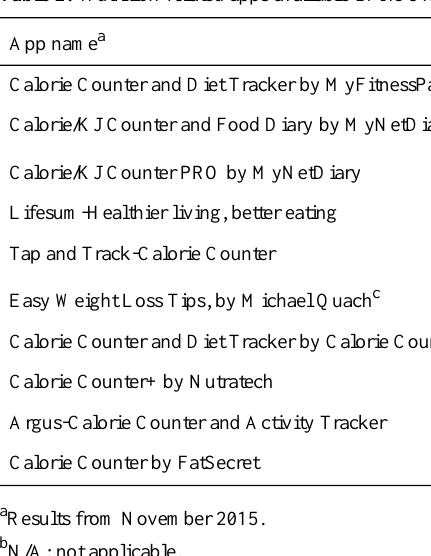
Table 2. Nutrition-related apps available in the UK iTunes App Store, ordered by number of